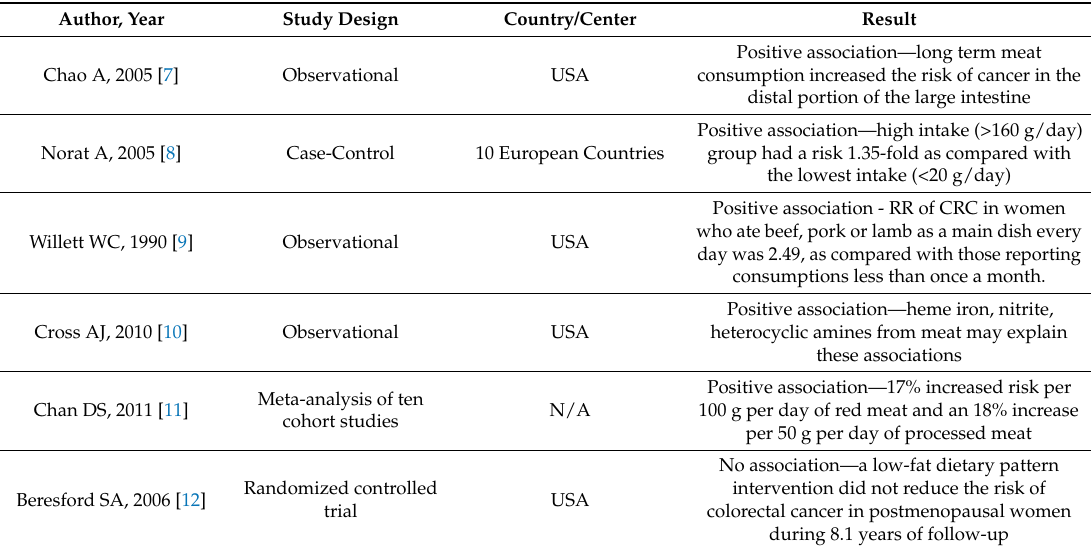
Table 1. Summary of major epidemiological studies examining the association of Red Meat Intake with